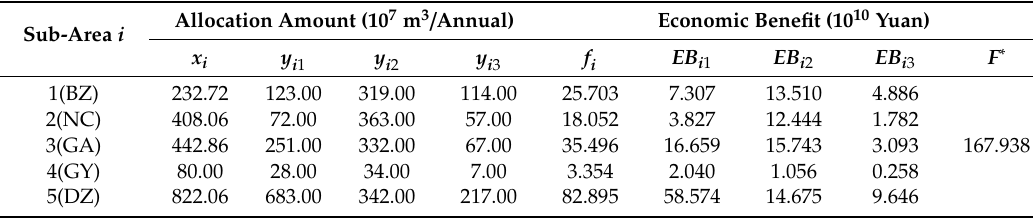
Table 4. Water allocation result under